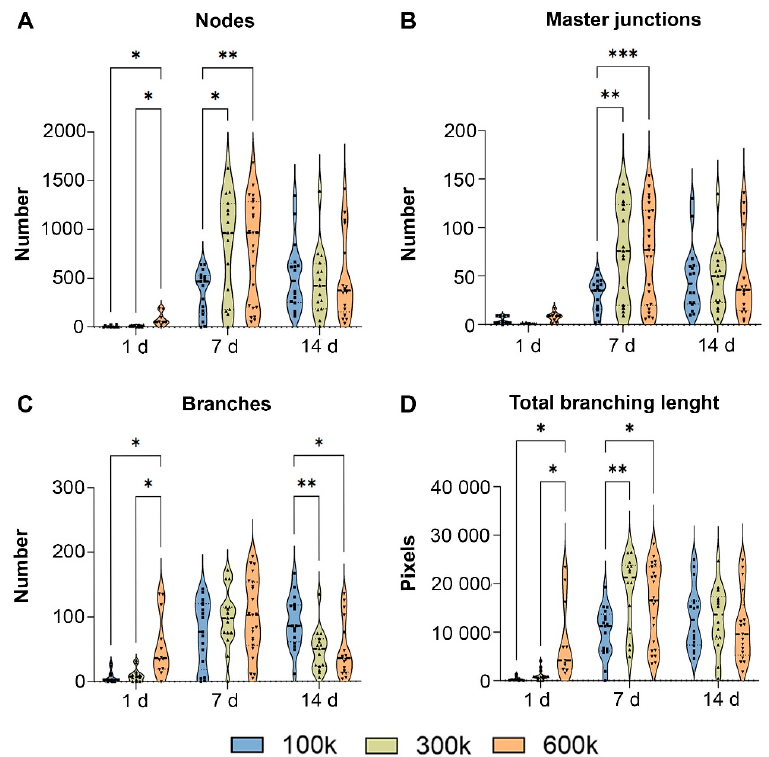
Figure 2. Quantitative analyses of VNF by HPMEC in LV ECM hydrogels. ( A ): comparison of the number of nodes based on ImageJ quantification among 100k, 300k, and 600k HPMEC at three time points (1 d, 7 d, and 14 d). ( B ): comparison of the number of master junctions based on ImageJ quantification among 100k, 300k, and 600k HPMEC at three time points (1 d, 7 d, and 14 d). ( C ): comparison of the number of branches based on ImageJ quantification among 100k, 300k, and 600k HPMEC at three time points (1 d, 7 d, and 14 d). ( D ): comparison of total branching length based on ImageJ quantification among 100k, 300k, and 600k HPMEC at three time points (1 d, 7 d, and 14 d). * p < 0.05, ** p < 0.01, **** p <<0.0001